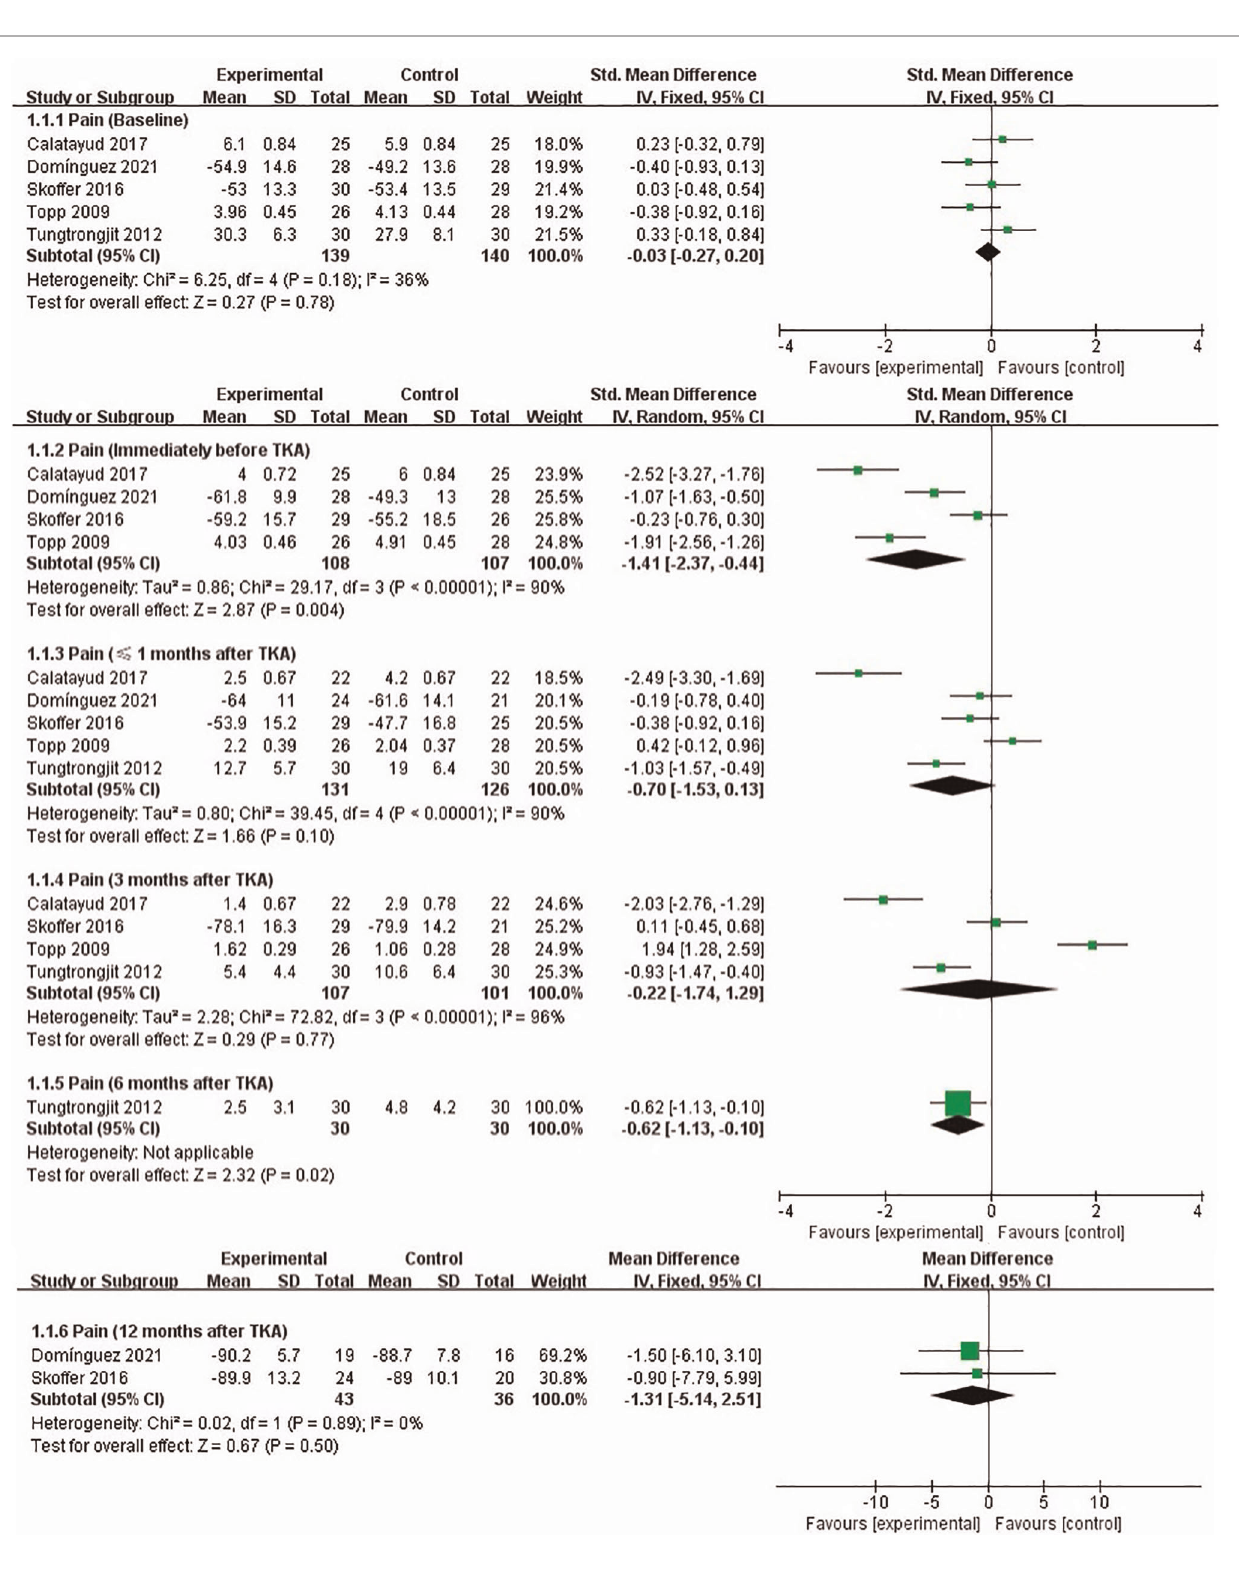
FIGURE 3 | Meta-analysis on